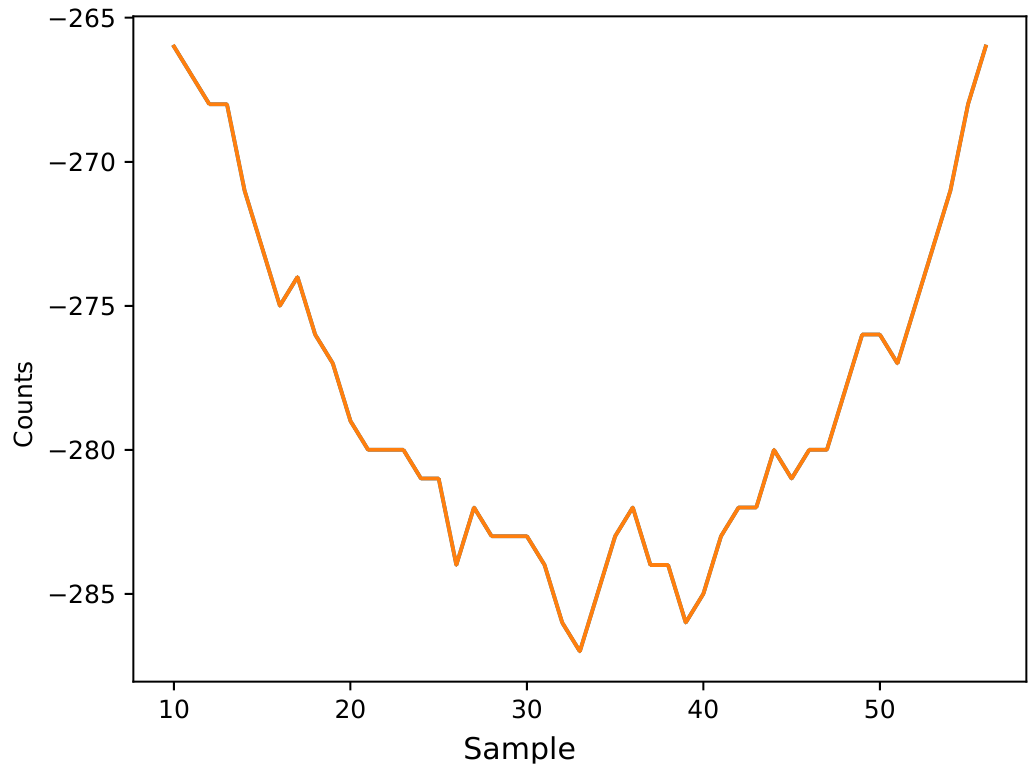
Figure 3. Signal from all samples taken during the calibration line performed by HIRS/4 on NOAA-19 on 2012-03-04 between 5:07:0.8 and 5:07:7.2 UTC. The first positions were excluded, because